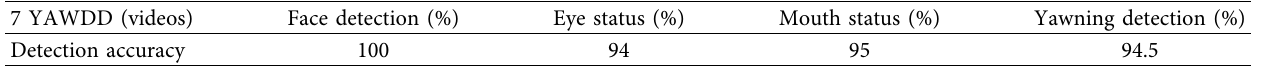
Table 6: Online YAWDD videos’ dataset analysis.